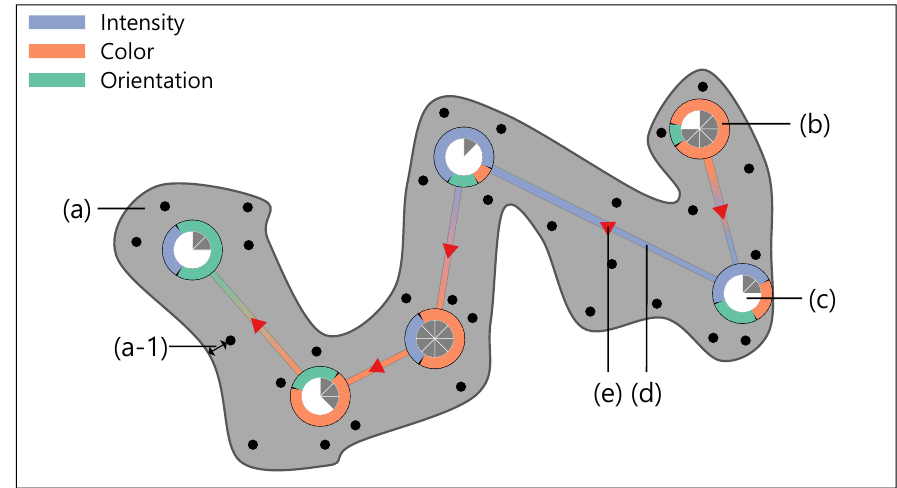
Figure 2. Saliency-based gaze visualization. (a) is the field of view. The raw gaze data points are rendered as the black dots on the field of view. Note that, in the analysis, we show only the field of view. (a-1) is a visual angle degree. The range of visual angle degree is 1 to 2 degrees [56] of the raw gaze point. (b) is the fixation with the saliency features. Intensity, color, and orientation are encoded in blue, orange, and green, respectively. The chart in (c) represents the fixation time with the pie slices. (d) is the link between fixations. The link color indicates the prominent saliency feature. (e) represents the gaze direction.